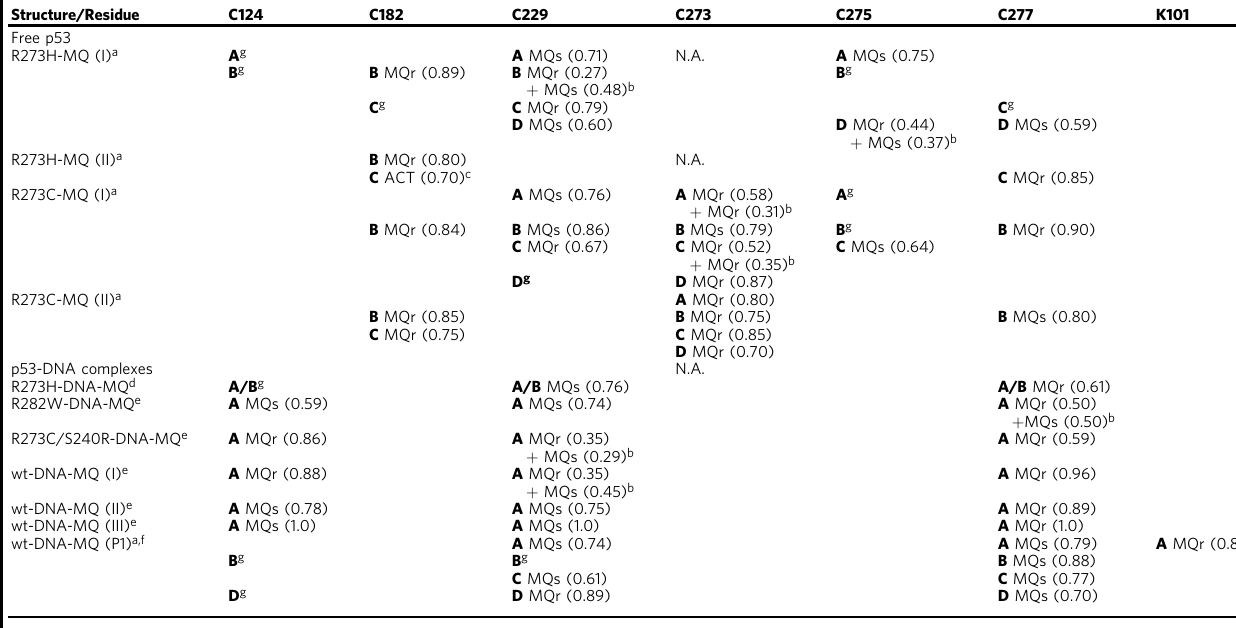
Table 1 Bound MQ observed in structures of free p53 core domains and p53-DNA complexes.